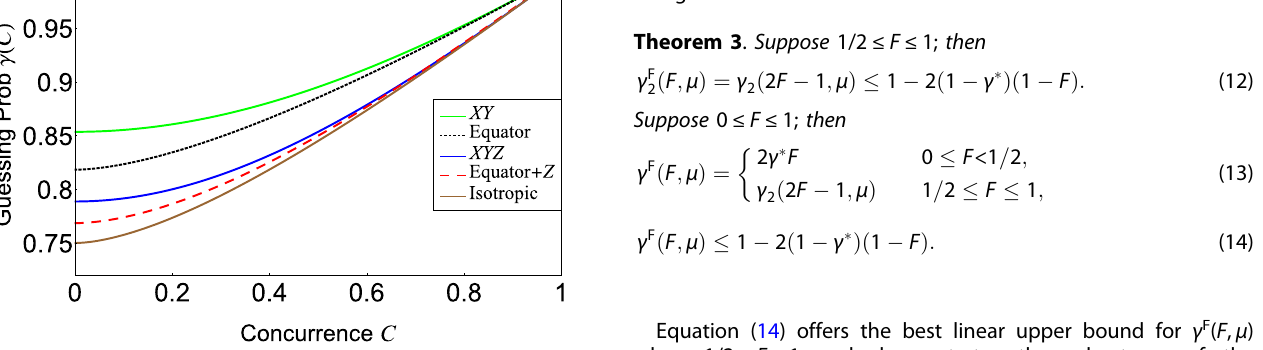
Fig. 2 The guessing probability γ ( C ) = γ 2 ( C ) as a function of the concurrence C for various veri fi cation protocols of the Bell state. Here the XY protocol and isotropic protocol are introduced in the main text, while other protocols are proposed in the Supplementary